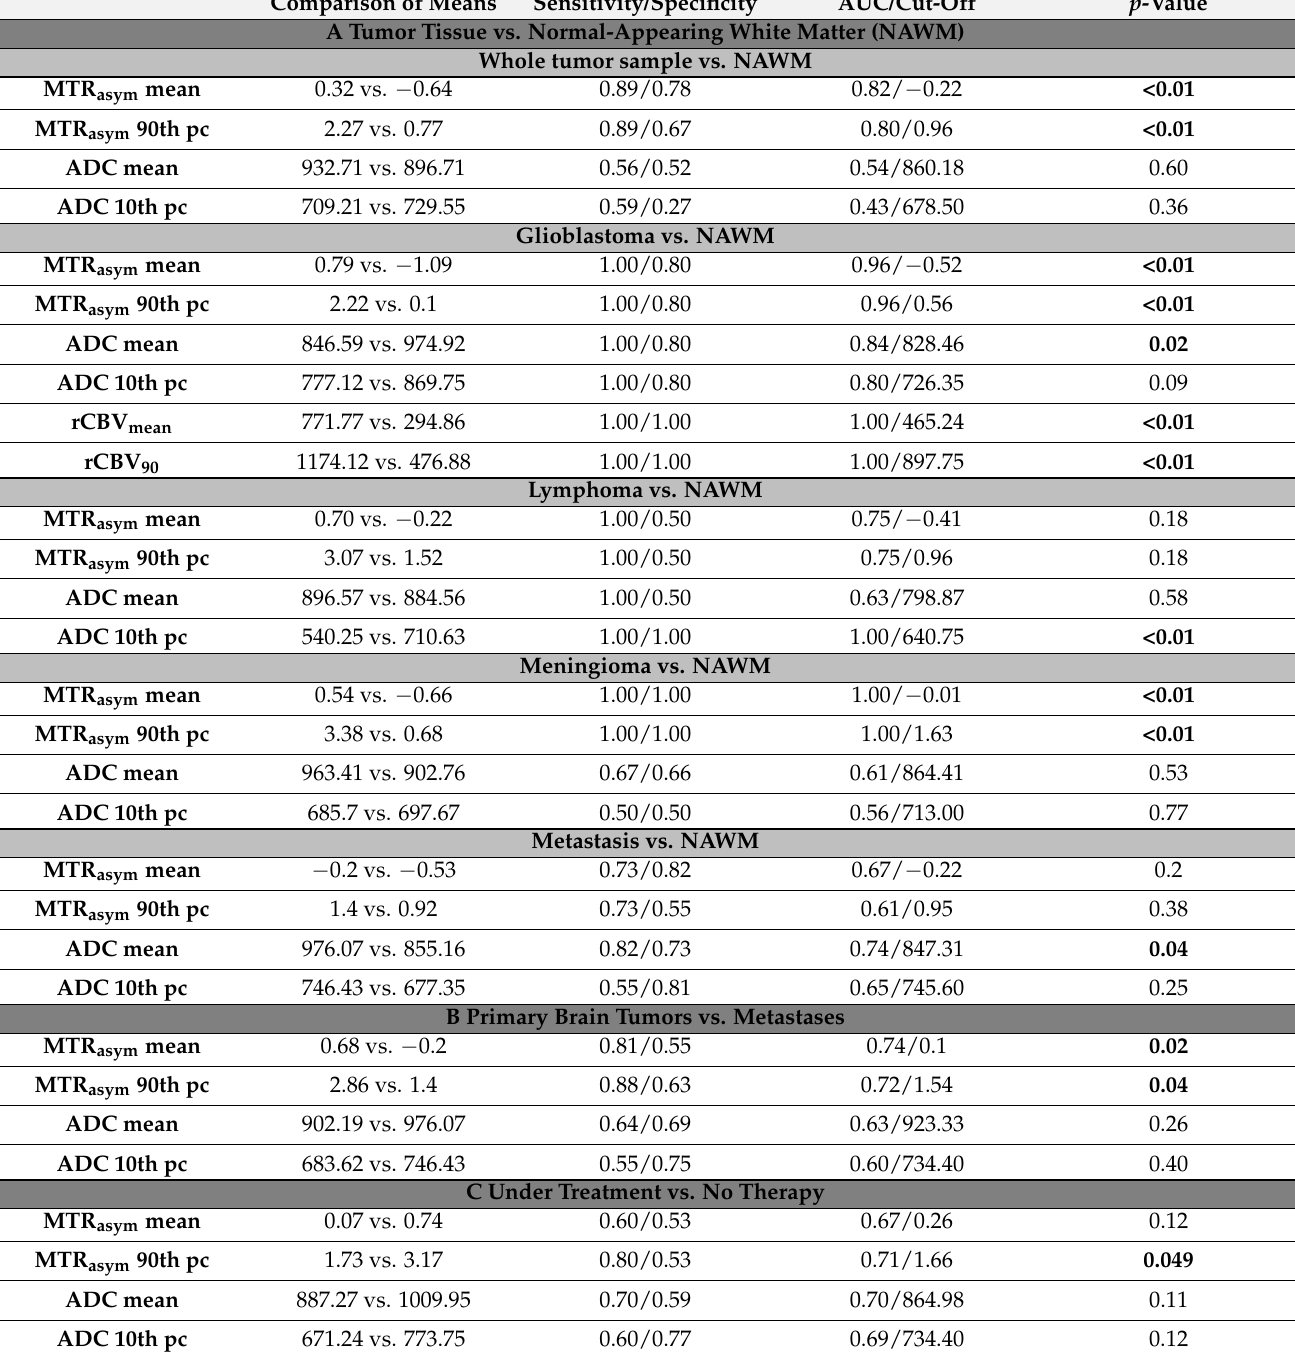
Table 2. Results of receiver operating characteristic analyses of MTRasym, ADC and rCBV at 3T CEST magnetic resonance imaging (MRI) in routine clinical